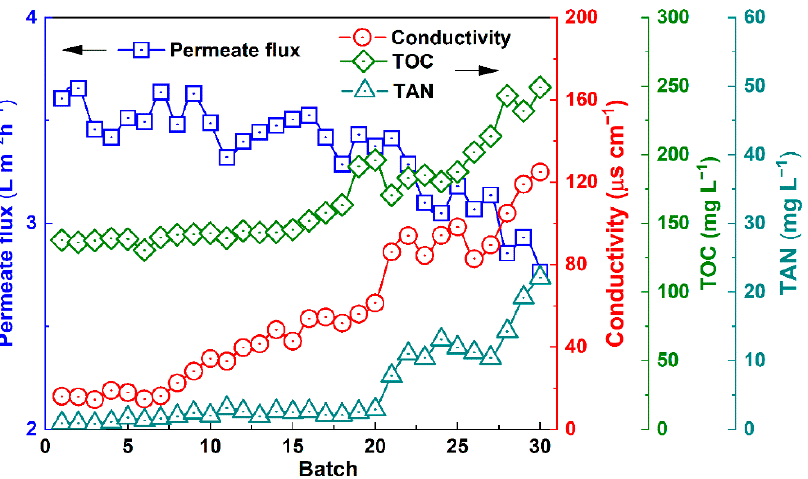
Figure 6. Changes in the distillate flux and conductivity, as well as the concentrations of TOC and TAN during the 30-batch operation (feed pH: 1.6, feed average temperature: 61 °C, permeate side pressure: 15.3 kPa).